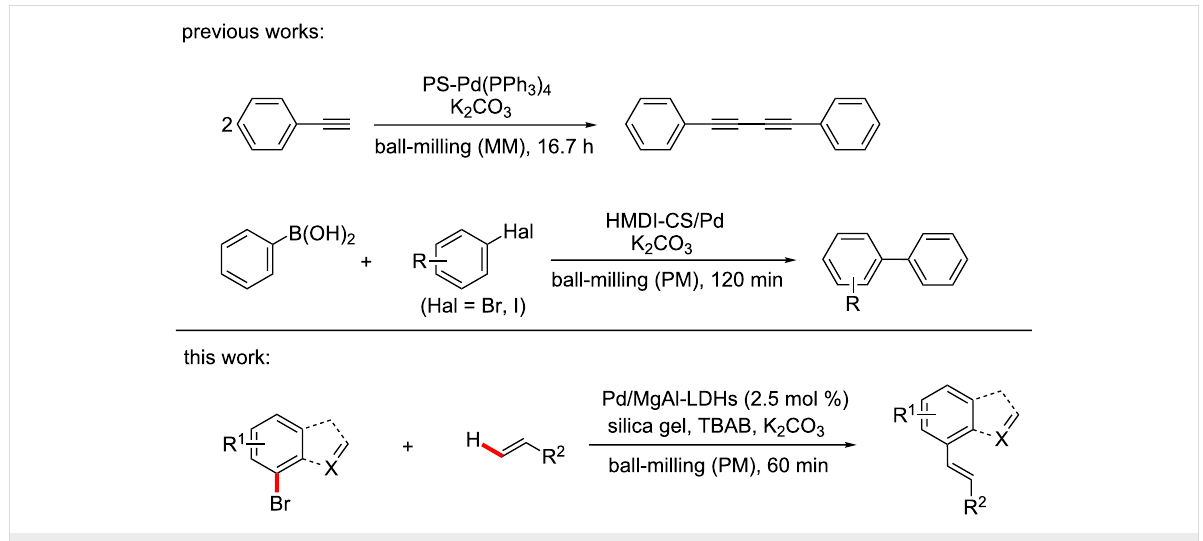
Scheme 1: Supported catalysts in cross-coupling reactions. MM represents mixer mill; PM represents planetary